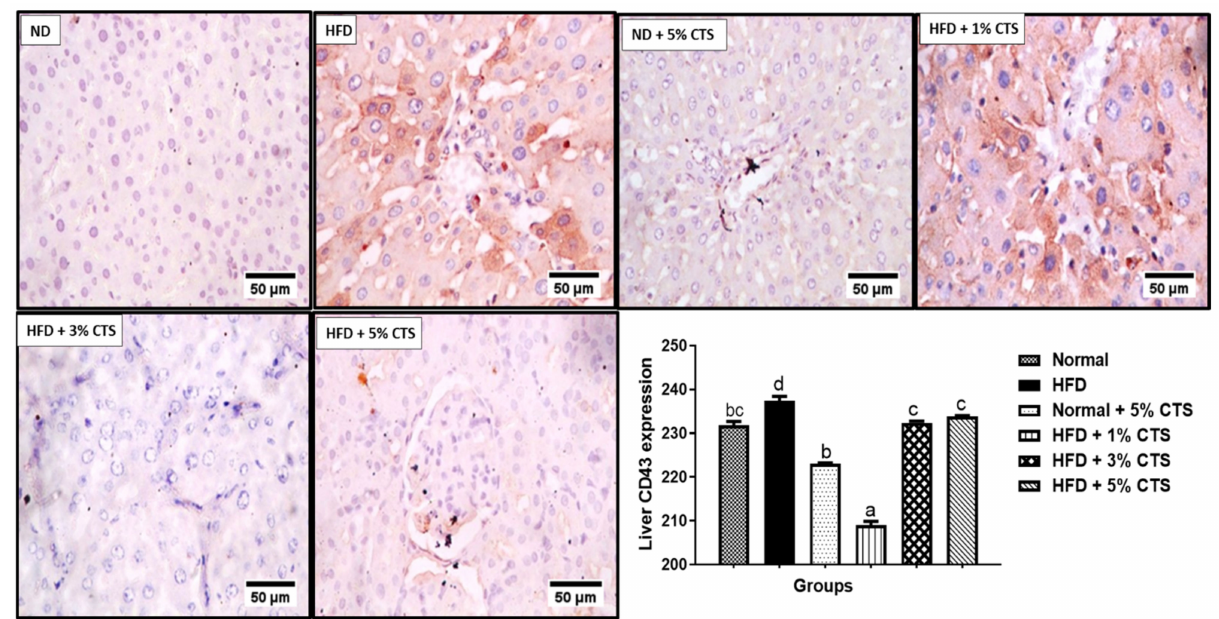
Figure 3. Photomicrograph of immunohistochemical expression of hepatic CD43. Values are expressed as mean ± SEM ( n = 3). Bars with distinct letters are statistically ( p < 0.05) different. ND–normal diet; HFD–high-fat diet; CTS–chitosan.